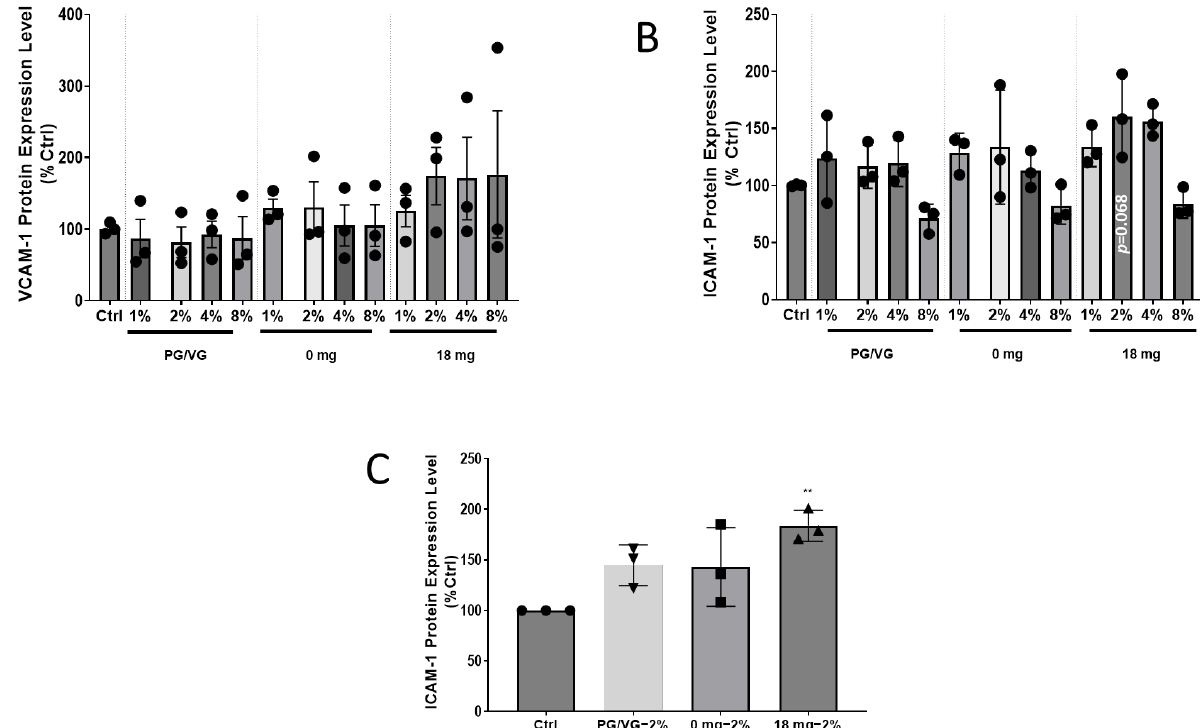
Figure 3. Expression of cellular adhesion molecules after exposure to EAC treatment. HCAEC were exposed to various concentrations of EAC generated from: (i) 0 mg nicotine (tobacco flavoured) and (ii) 18 mg nicotine (tobacco flavoured) for 24 h. ( A ) VCAM-1 protein expression. ( B ) ICAM-1 protein expression. ( C ) Indirect effects of EAC on ICAM-1 protein exposure. A549 epithelial lung cells were exposed to EAC under the same conditions. Media from the treated A549 cells were then used to treat HCAEC on a separate plate for 24 h before measuring ICAM-1 protein levels. Results are expressed as mean ± SEM (n = 3 biological replicates). One-way ANOVA with Bonferroni post-tests was used for statistical analysis, ** p < 0.01 versus Ctrl.